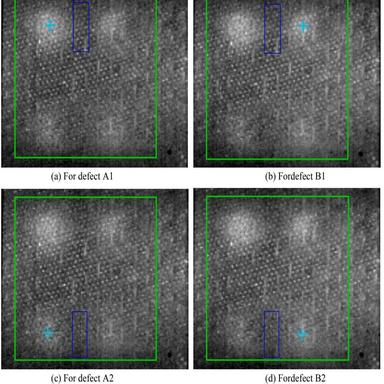
The excess temperature images of sample B taken at the time of maximum temperature difference of each defect, and the sound zone selected for detection evaluation.